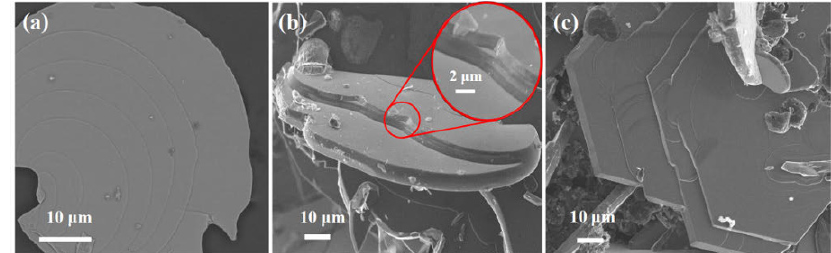
Fig. 4 SEM images of synthesized Al 4 SiC 4 grains with different morphologies. (a) Grain with shallow smooth edges and striations; (b) grain with thick smooth edges and striations; (c) the well-developed grain with straight edges and sharp